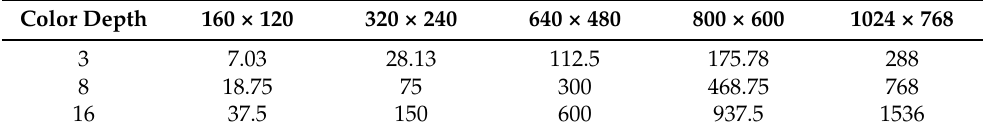
Table 2. Image size in storage space (unit: